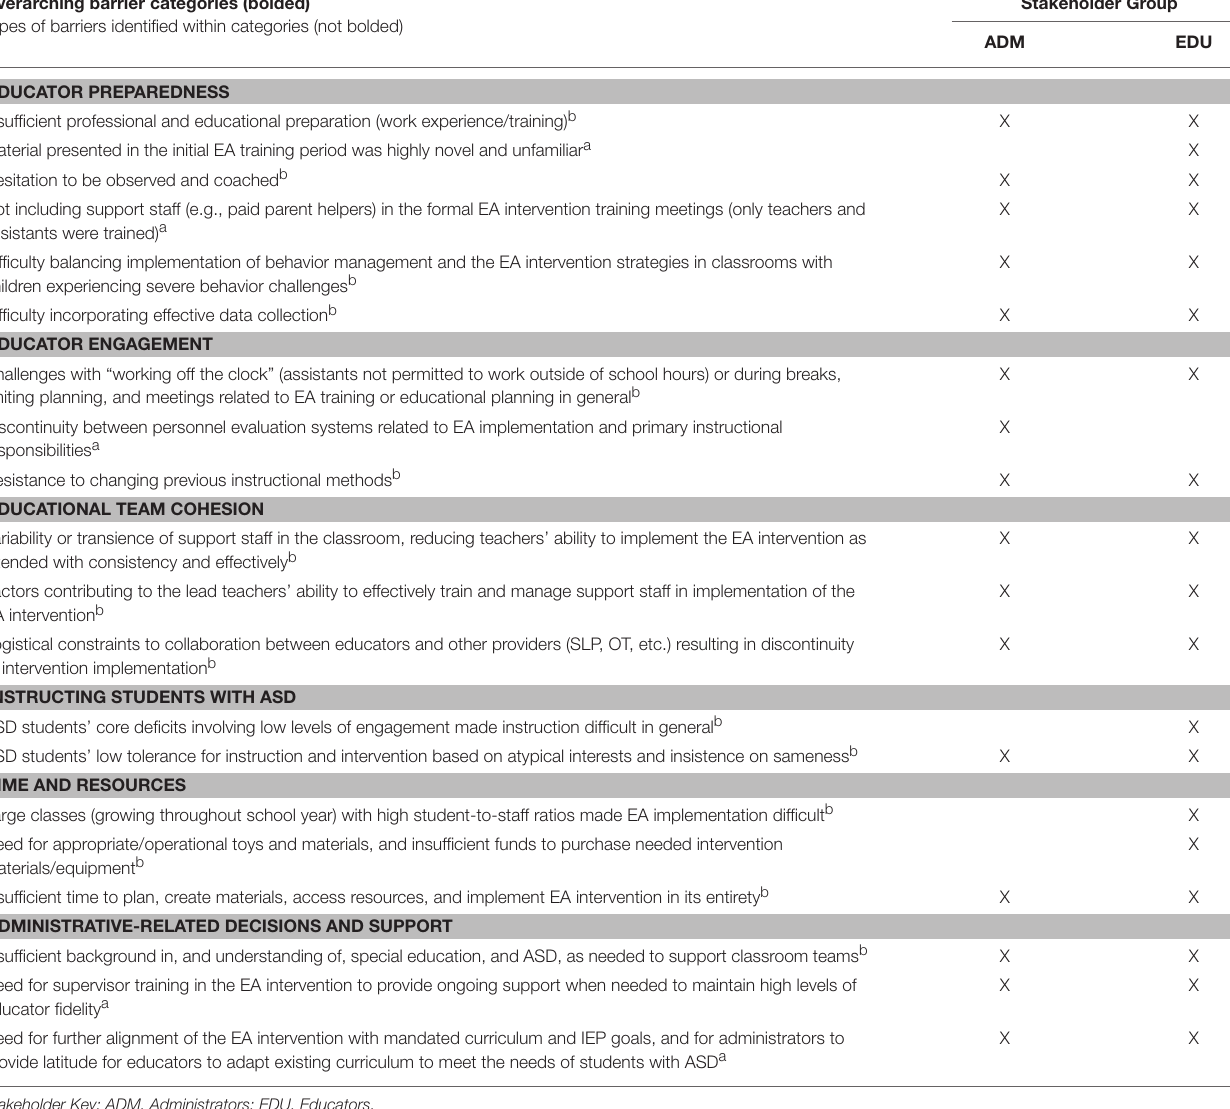
TABLE 3 | Barriers identified by